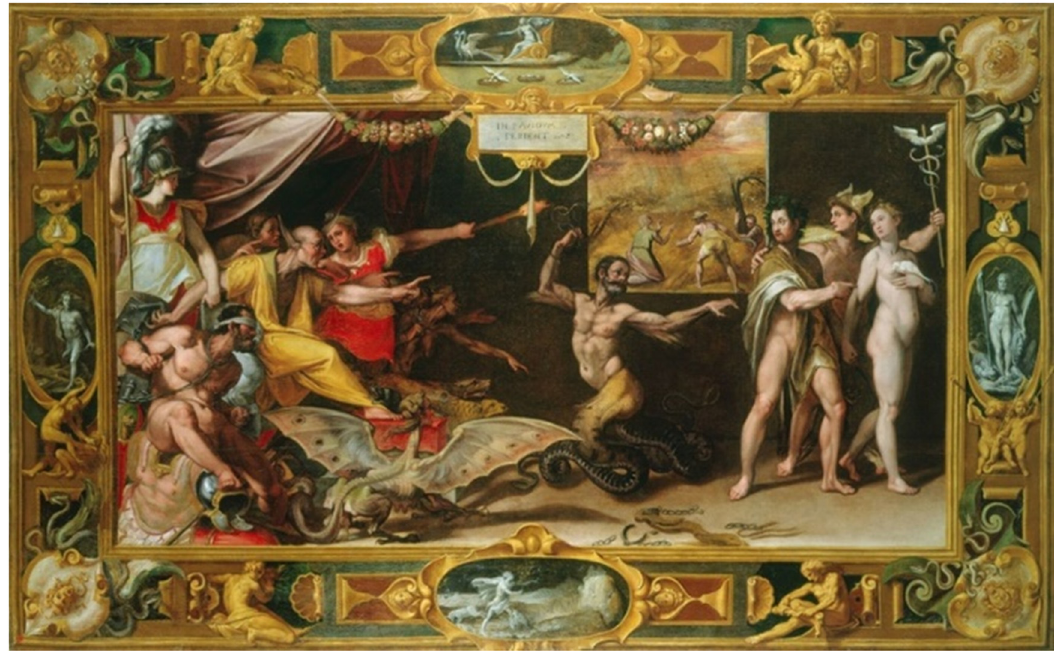
Figure 13: Federico Zuccaro, Calunnia di Apelle , 1569. Art Collection of the British Royal